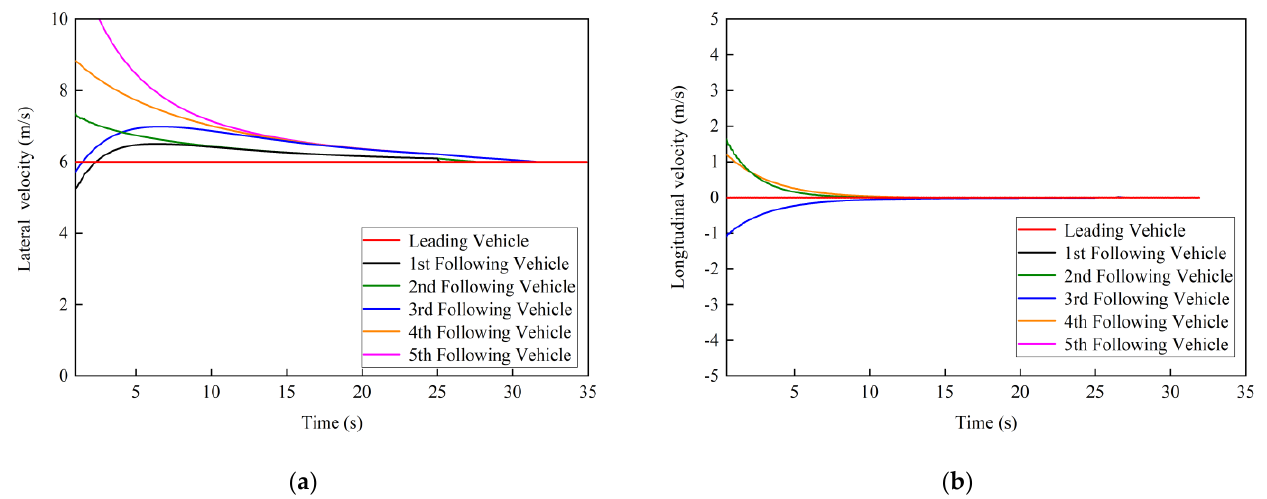
Figure 10. The velocities of the CAVs during the platoon formation process: ( a ) lateral velocity; ( b ) longitudinal velocity (scenario III).